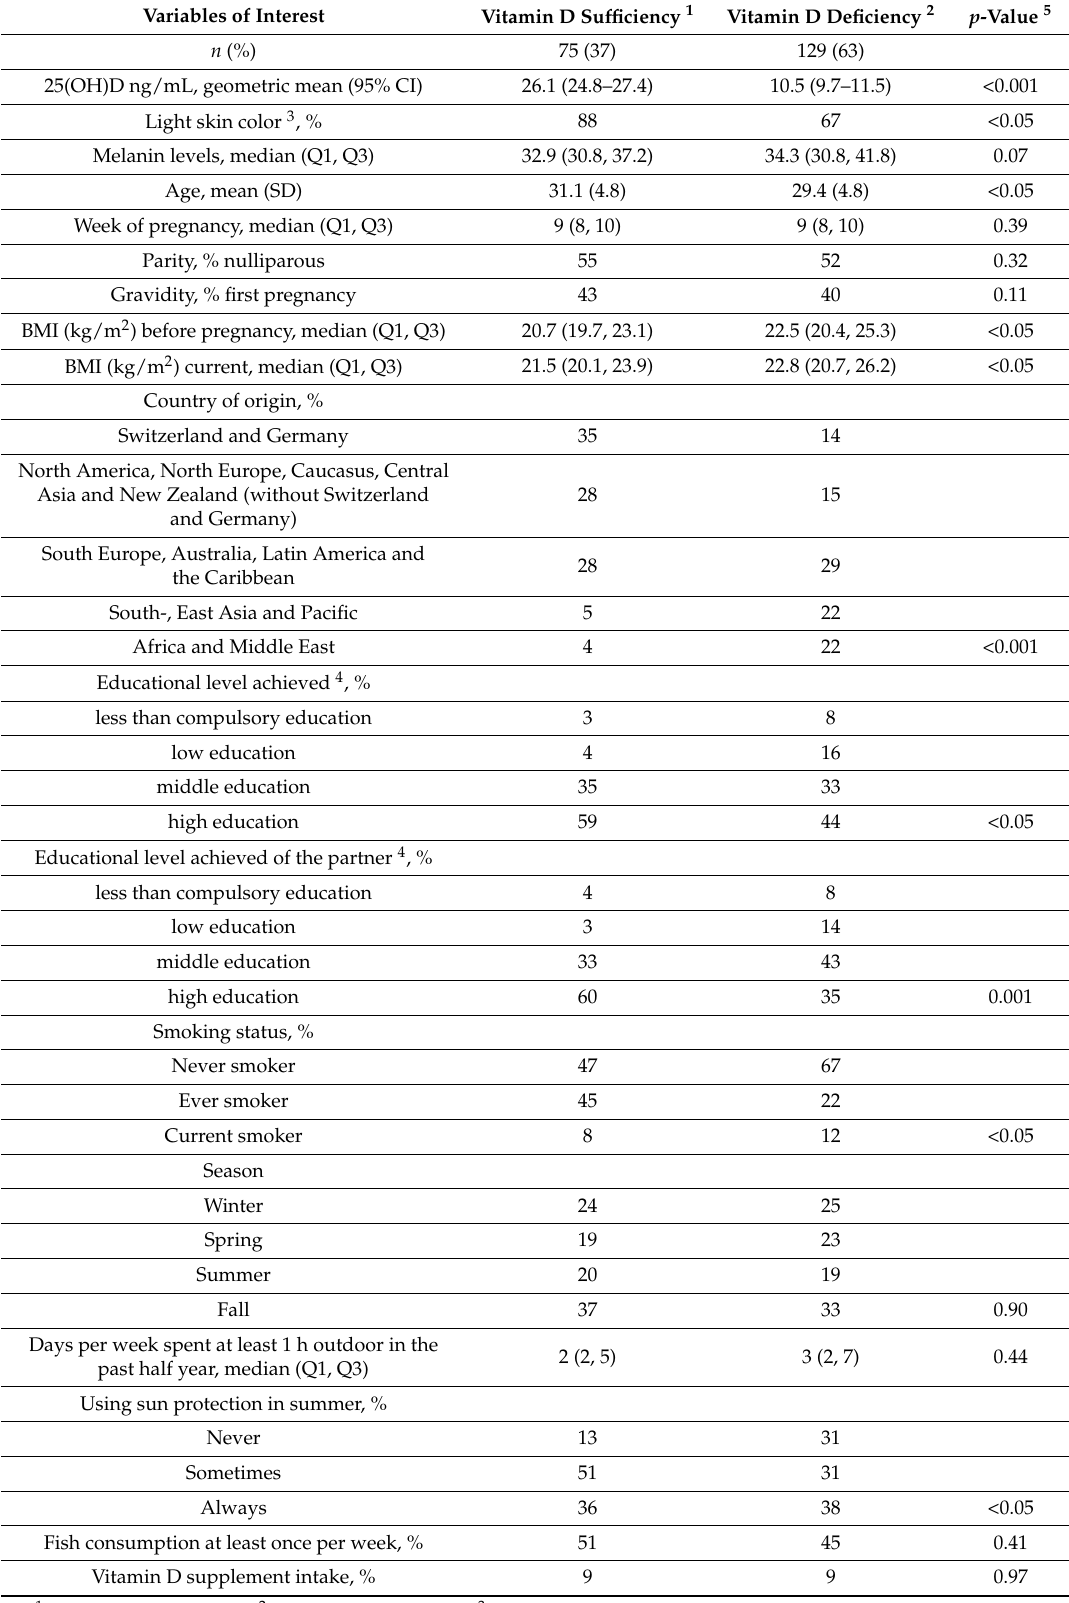
Table 1. General characteristics of pregnant women by vitamin D